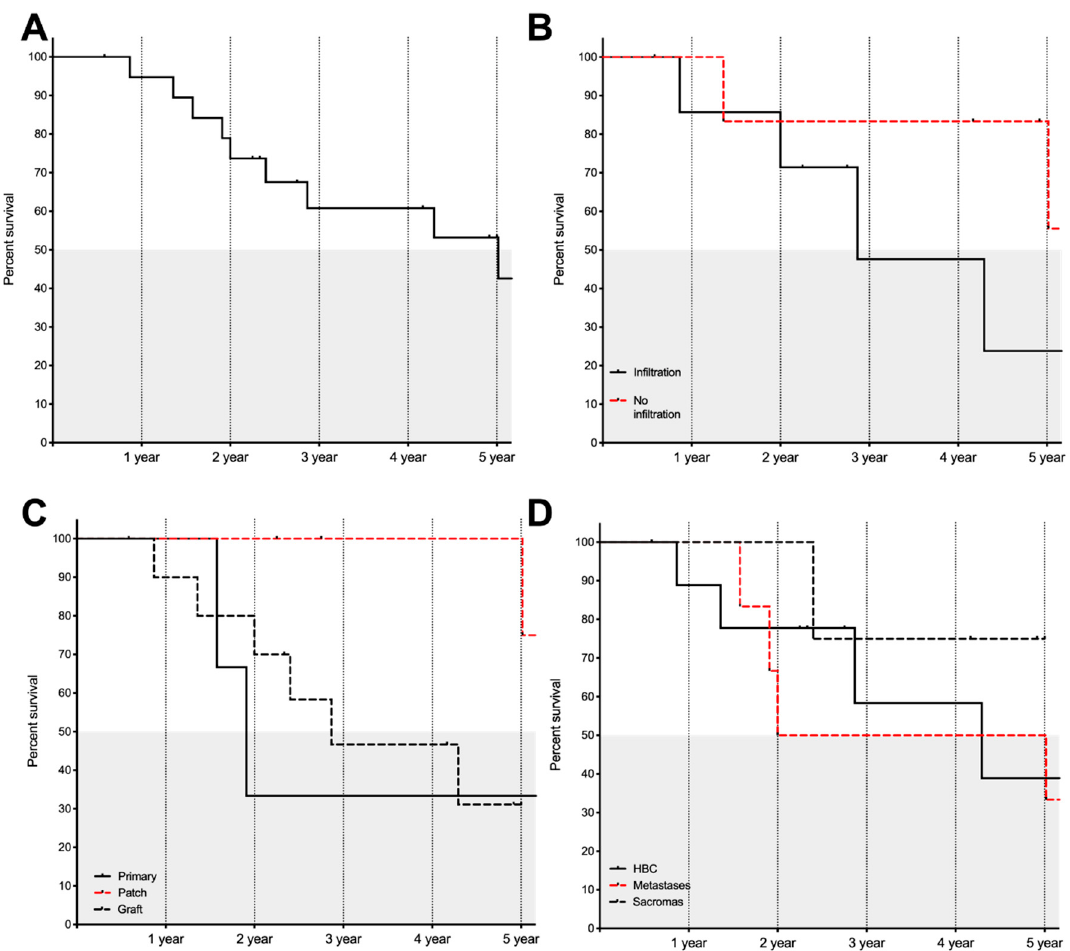
Figure 3. Kaplan–Meyer survival curves. On the x-axis the time in years is shown, while the y-axis shows the percentage of patients surviving. ( A ) Overall survival for all patients is shown. ( B ) The survival times in relation to the infiltrative status into the ICV are shown. There was a trend for improved survival in the group without infiltration into the ICV. ( C ) The survival status in relation to the type of reconstructive surgery of the ICV is shown. Patient with a patch reconstruction had a significantly better survival than patients receiving a graft or a primary closure of the ICV. ( D ) The survival in relation to the oncological indication is displayed.